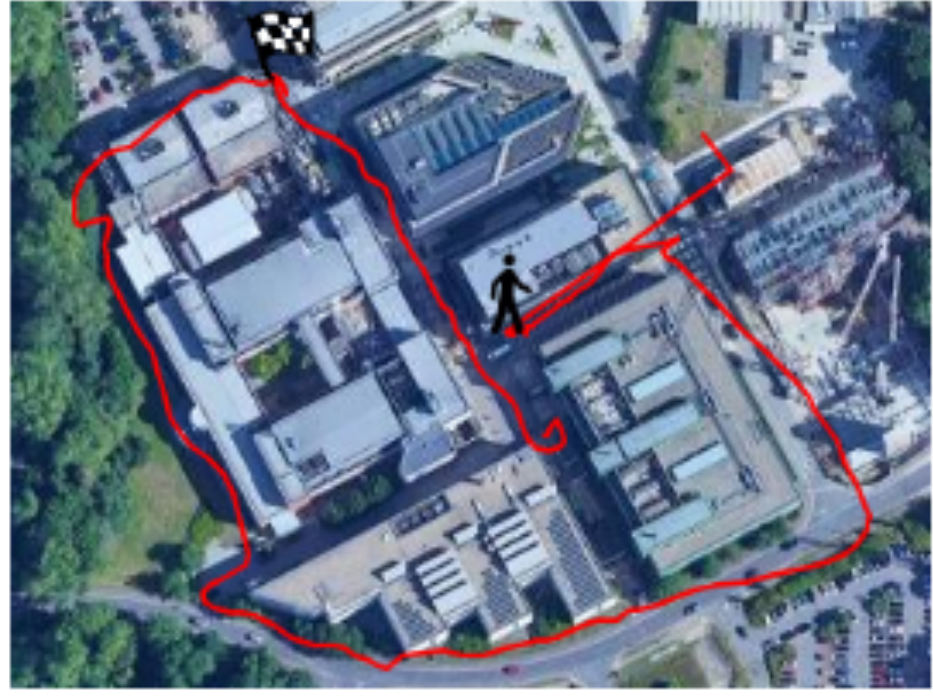
Figure 3. Example of a positioning trace (in red) retrieved from the mobile phone. The walking man figure indicates the starting point of the test; the flag indicates its end. Comparing the trace with the underlying picture shows that the position is sometimes affected by an error, for example, near tall buildings which reflect the signal or because of trees obscuring the global positioning system satellite’s signal.